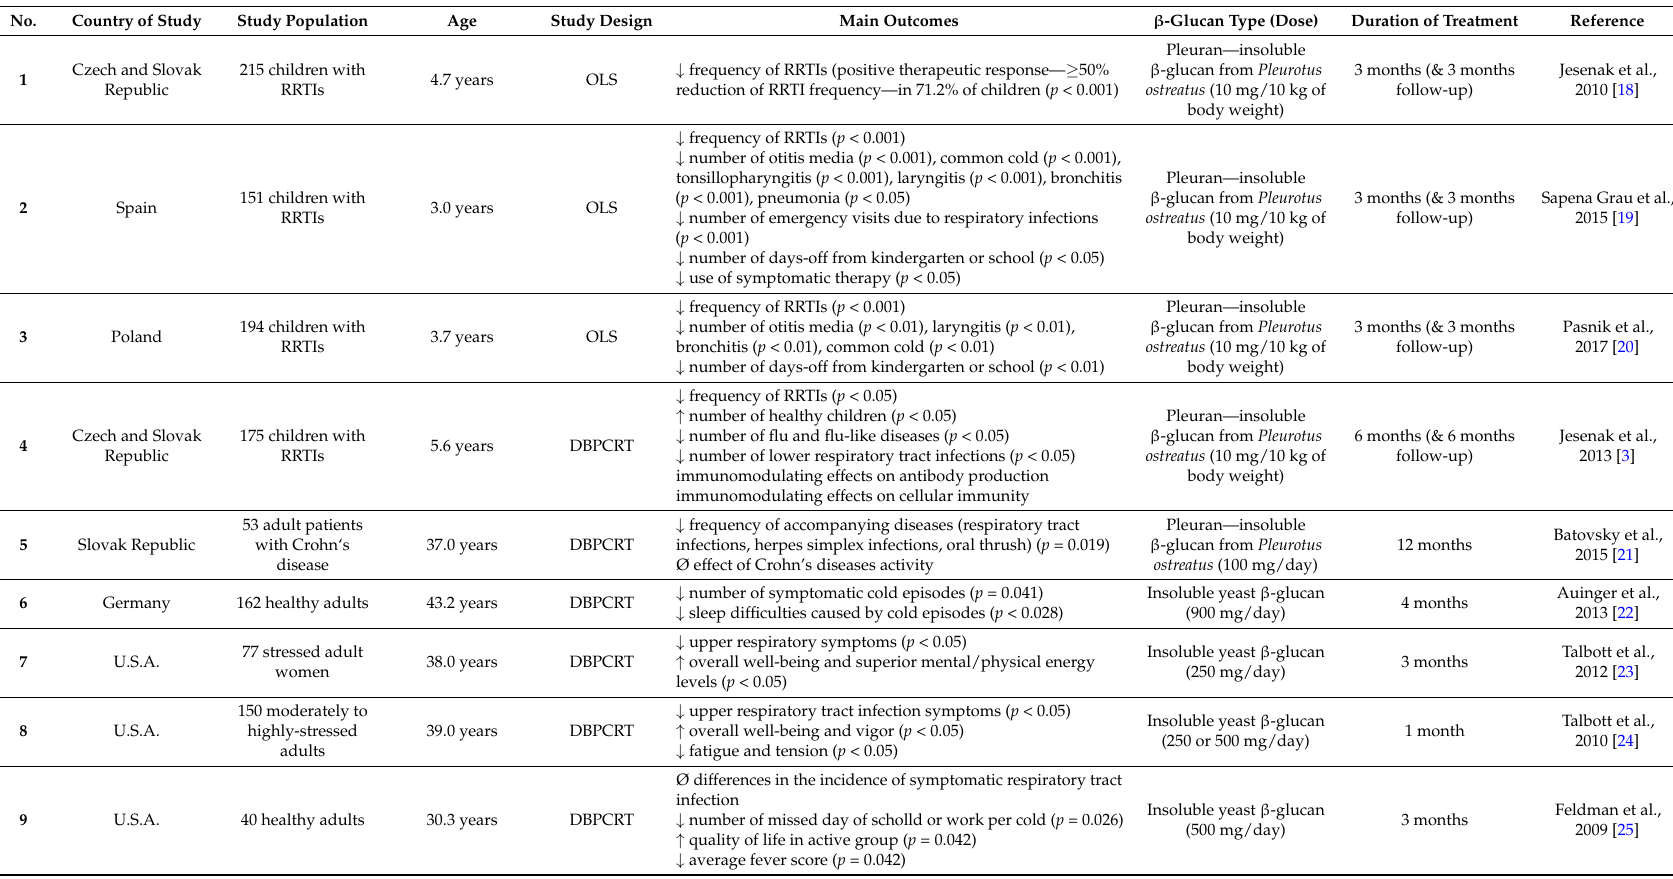
Table 1. Effect of β -glucans of different origin on the respiratory tract infections and selected parameters in children and